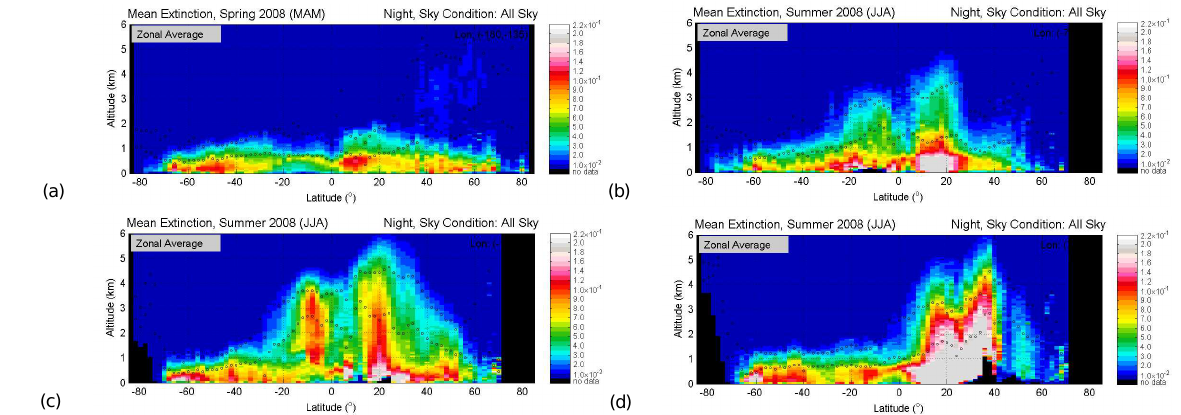
Fig. 11. Regional zonal aerosol extinction (km − 1 ), 2008: (a) 180–135 ◦ W, MAM; (b) 75–40 ◦ W, JJA; (c) 15 ◦ W–30 ◦ E, JJA; (d) 70–90 ◦ E,